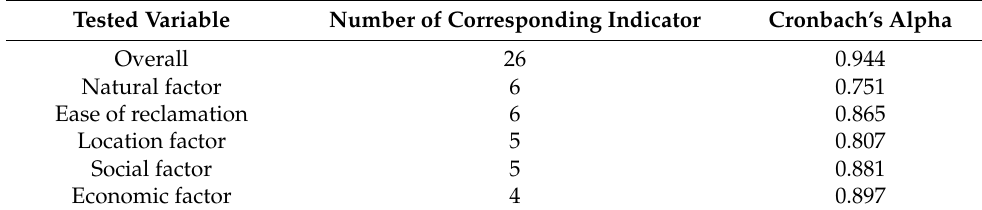
Table 2. Results of the reliability test.